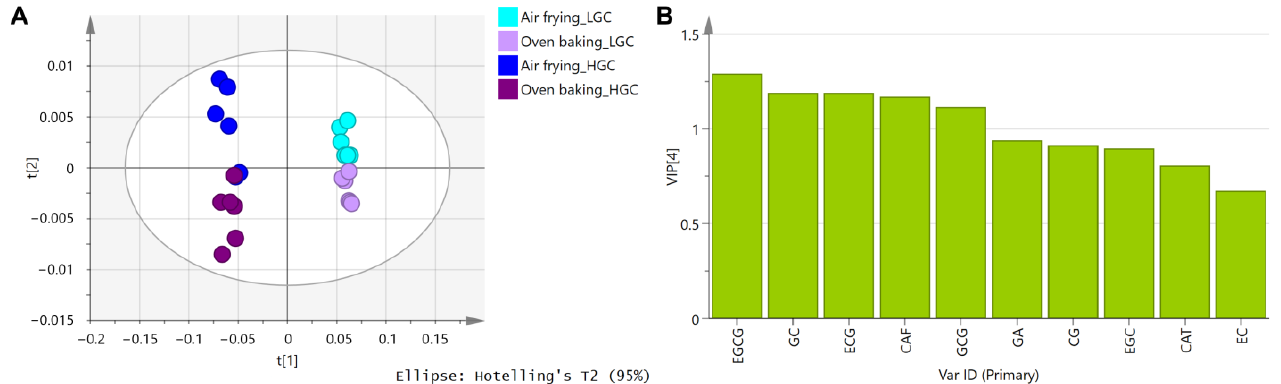
Figure 3. Chromatographic analysis of green tea-fortified cupcakes. ( A – C ) HPLC chromatography of GTCs in the green extract, air-fried HGCs, and oven-baked HGCs. ( D ) HPLC chromatography of GTCs in air-fried EGCG-fortified cupcakes. A 94 mg amount EGCG was added to each 20 g of cupcake mix. ( E ) HPLC chromatography of the control air-fried cupcakes. The wavelength was set at 273 nm and the addition level of green tea extract was Level 2 (94 mg of EGCG in 20 g of cupcake mix). GA, gallic acid; GC, (−)-gallocatechin; EGC, (−)-epigallocatechin; CAF, caffeine; CAT, (+)-catechin; EC, (−)-epicatechin; EGCG, (−)-epigallocatechin-3-gallate; GCG, (−)-gallocatechin-3-gallate; ECG, (−)-epicatechin-3-gallate; CG, (−)-catechin-3-gallate.